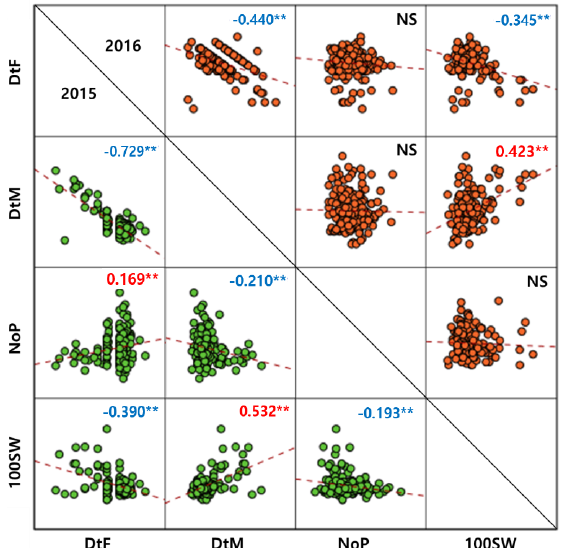
Figure 2. Scatter diagrams for flowering, maturity, number of pods, and seed weight in 203 wild soybean accessions for 2015 (green) and 2016 (orange). DtF, days to flowering; DtM, days to maturity; NoP, number of pods; 100SW, 100-seed weight. **, significant at p ≤